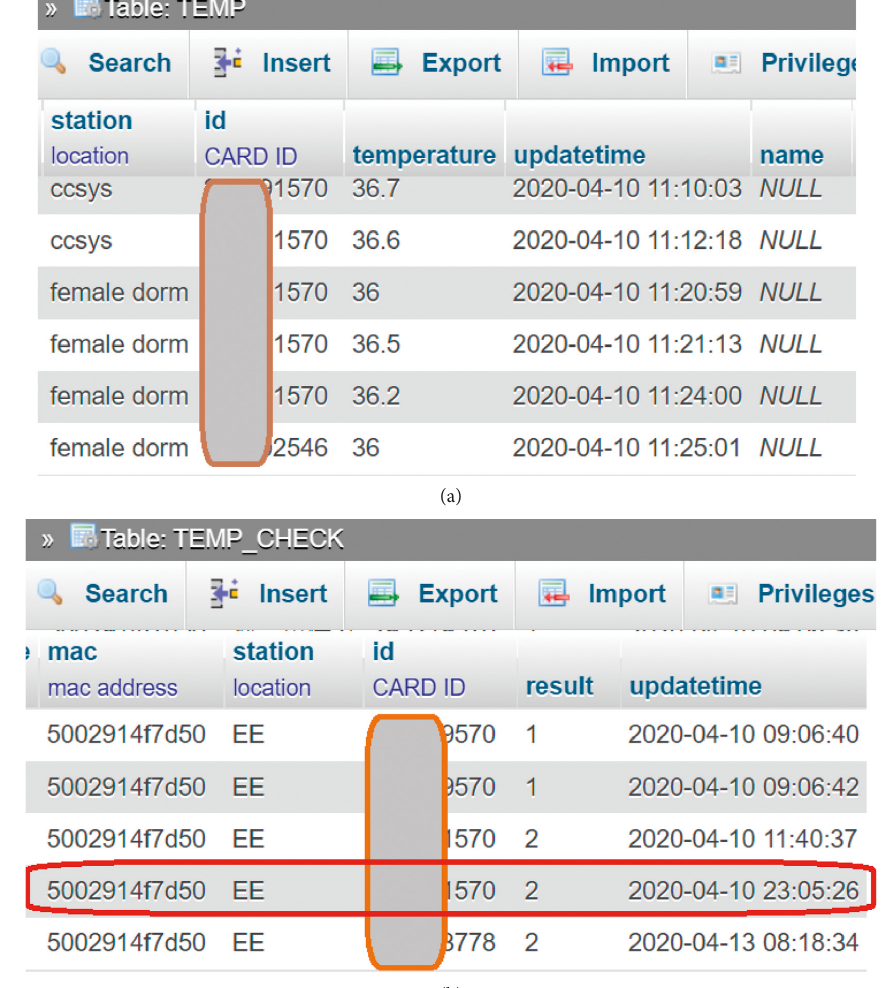
Figure 15: Screenshots of temperature records at different stations (a) and a corresponding footprint record captured by a card screener